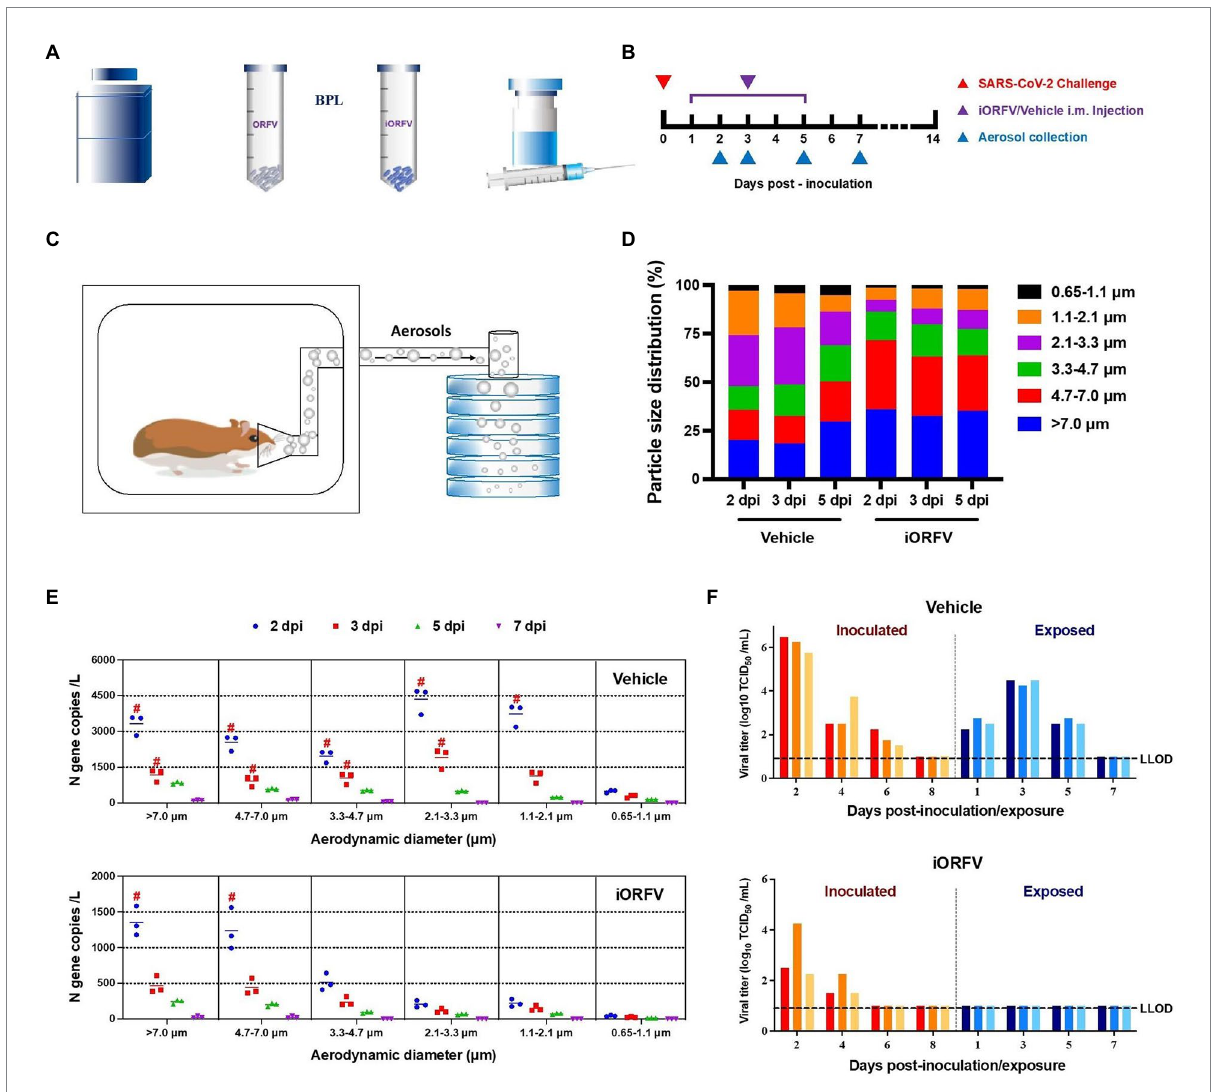
FIGURE 1 The effect of iORFV on viral aerosol distribution and transmission in hamsters. (A) Schematic map of the preparation of inactivated ORFV. (B) Schematic design of iORFV i.m. treatment for 5 consecutive days after SARS-CoV-2 challenge in hamsters. (C) Hamster-exhaled aerosols were collected and analyzed in a 6-stage Andersen sampler. (D) The particle size distributions of aerosol exhaled in the two groups of hamsters at 2, 3, 5 dpi. (E) Quantity and size distribution of exhaled viral particle-loaded aerosols in SARS-CoV-2-inoculated hamsters at 2, 3, 5 and 7 dpi. The red # indicates that infectious virus was detected in the aerosol sample. (F) SARS-CoV-2 was transmitted from donor to recipient hamsters (aerosol- exposed hamsters) under treatment with either vehicle or iORFV. Nasal washes were collected and analyzed from both donor and recipient hamsters. The lower limit of detection (LLOD) for viral titers is indicated with a black dotted